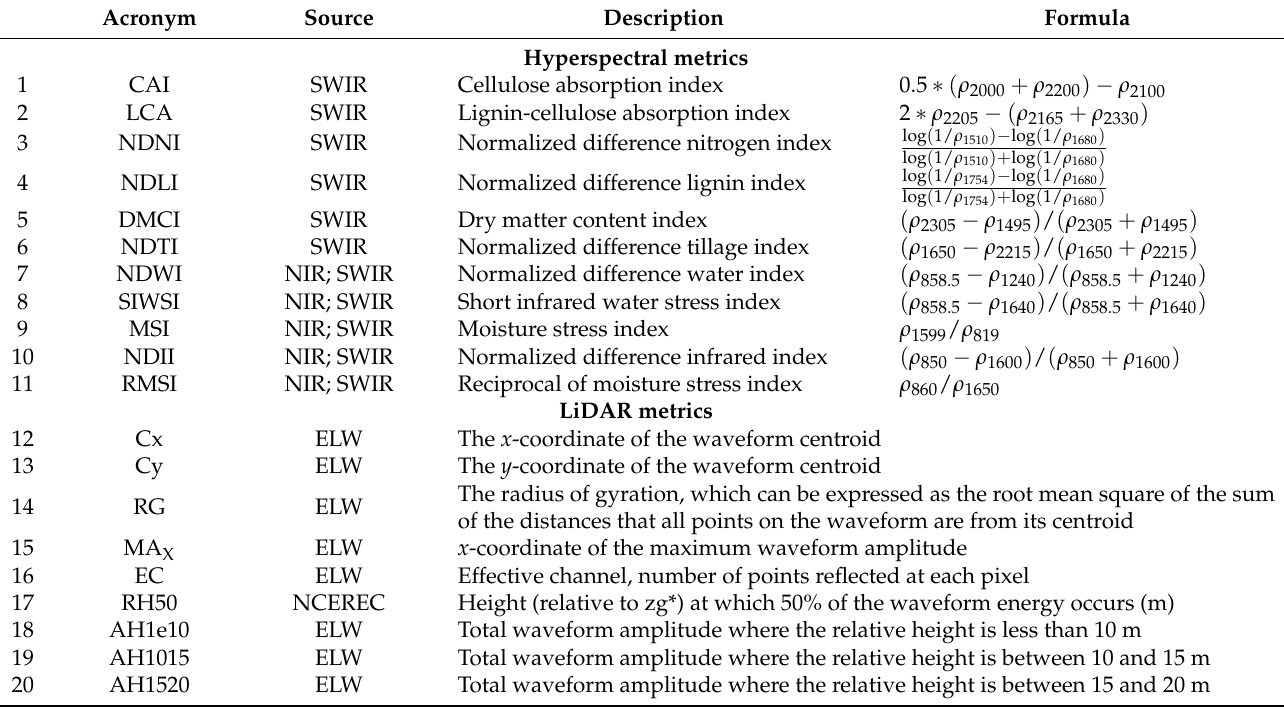
Table 1. Summary of HyMap and LiDAR metrics